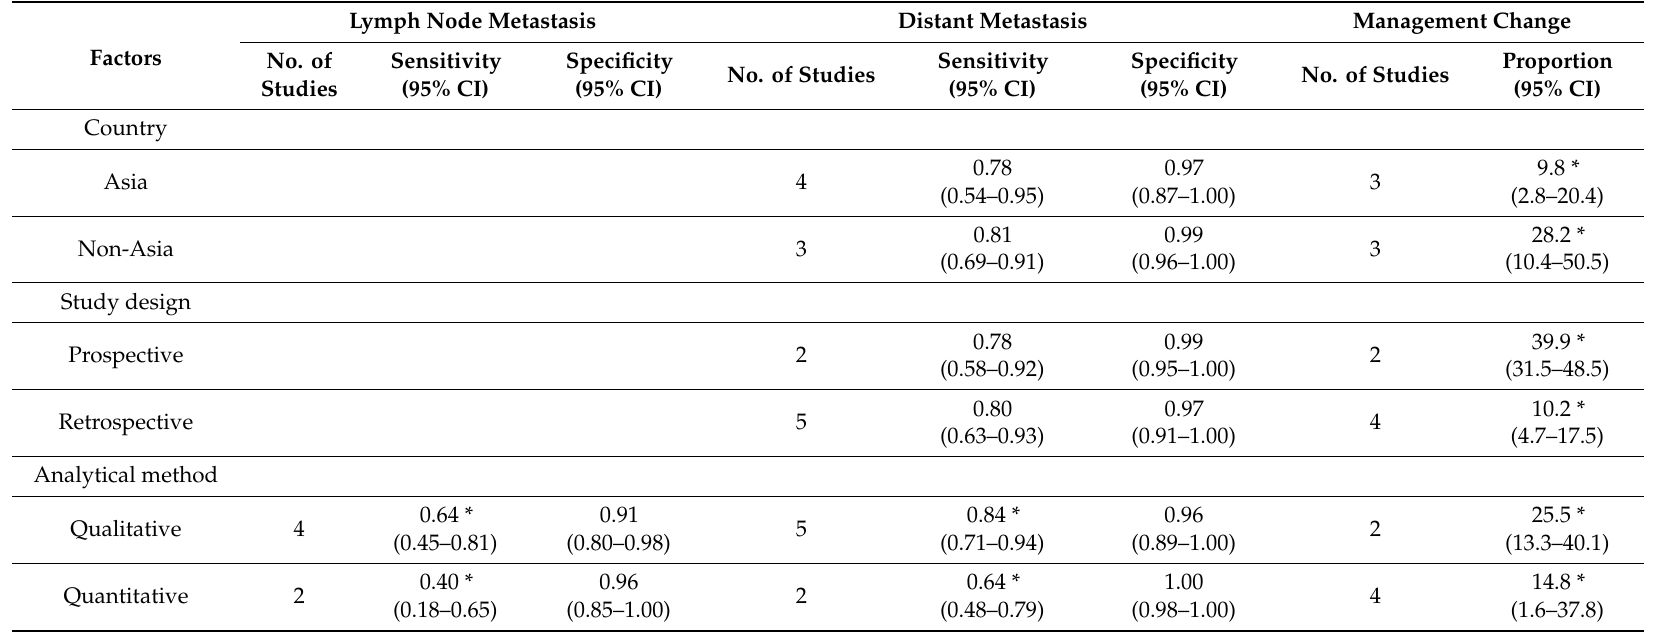
Table 2. The results of subgroup